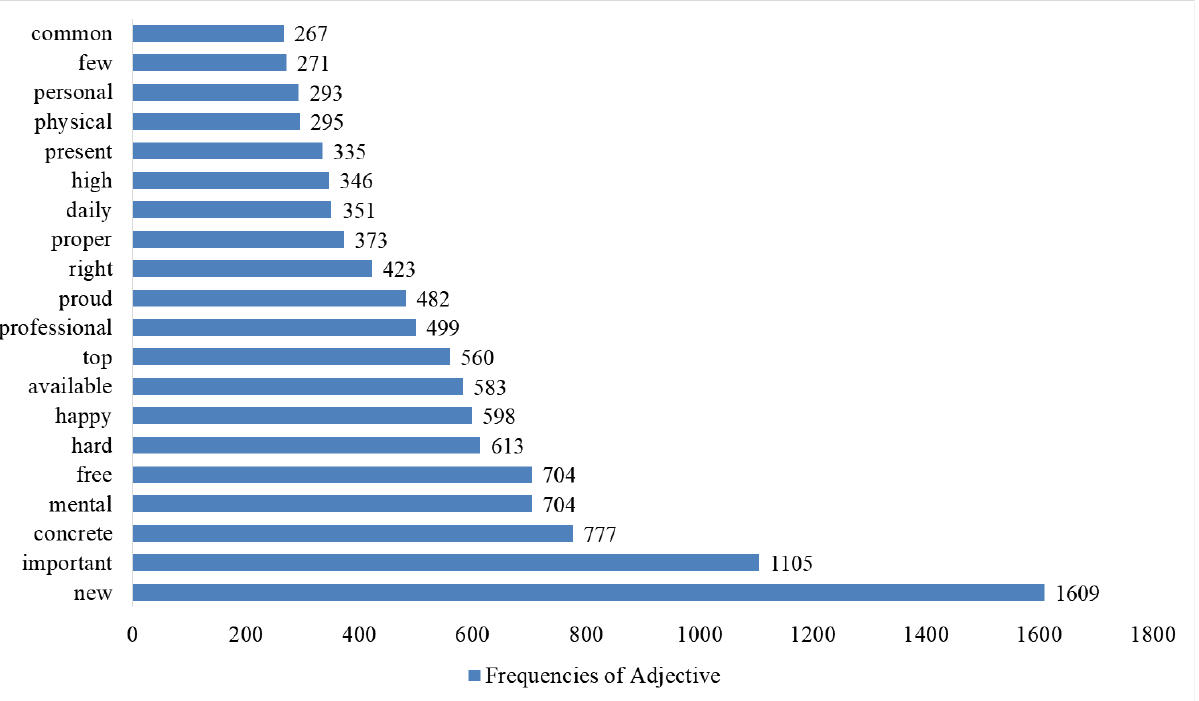
Figure 8. Frequencies of adjectives about the sentiment analysis on construction health and safety.